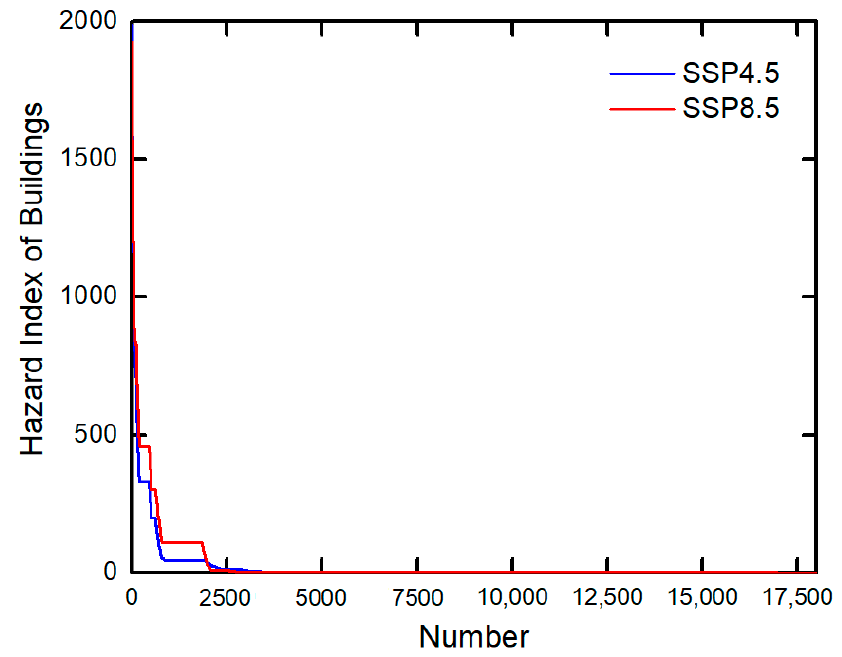
Figure 8. Map of hazard index for buildings (SSP8.5).